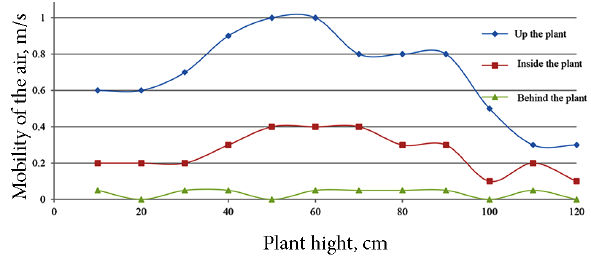
Figure 4. The modification of air mobility within the capacity of the plant cover